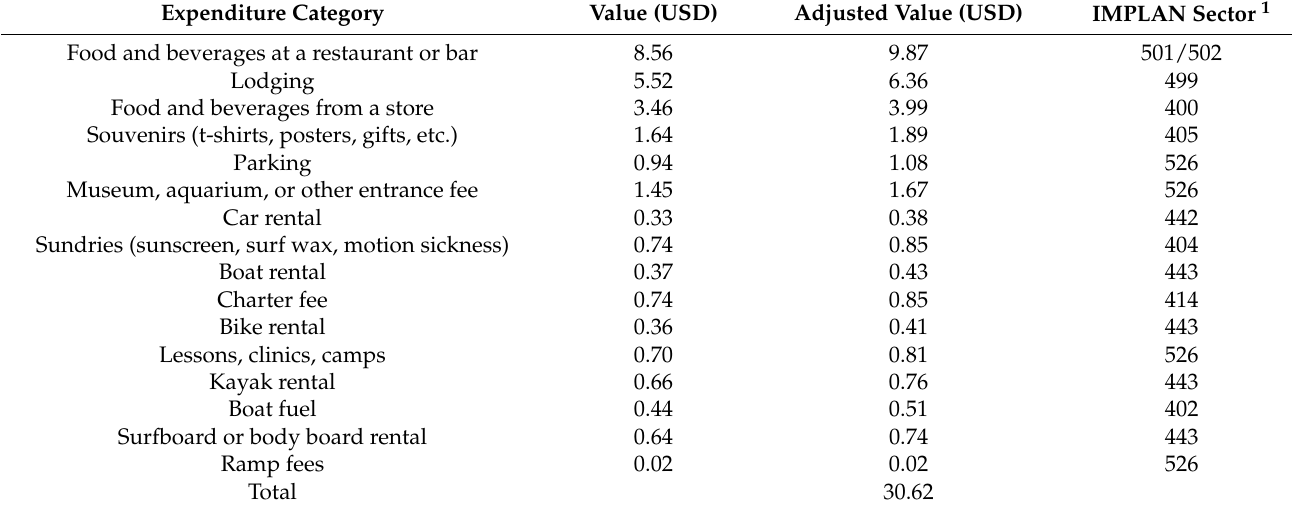
Table 2. Per-person-per-day visitor expenditures by